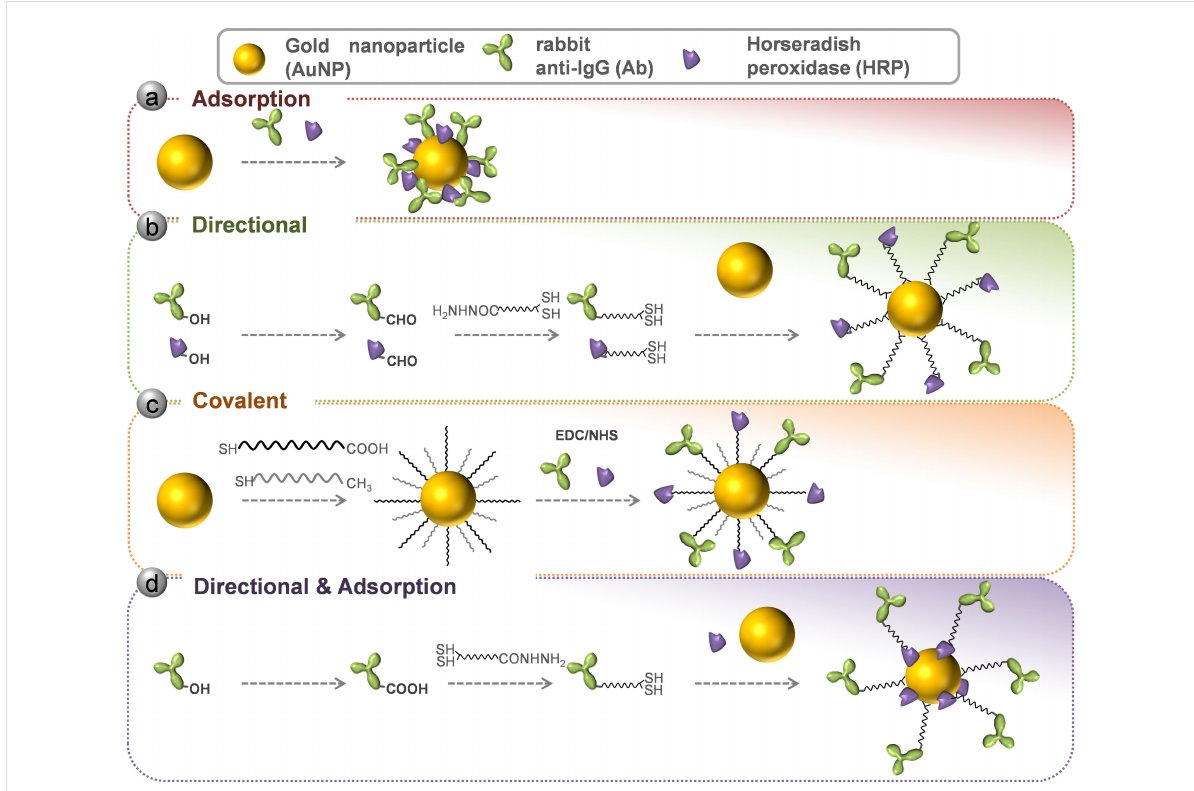
Figure 1: Schematic representation of the four different functionalization methods explored in this work. (a) Direct adsorption. (b) Directional conjuga- tion with control of antibody and HRP orientation. (c) Covalent conjugation through antibody and HRP amine groups. (d) Combination of directional and adsorption strategy for antibody and